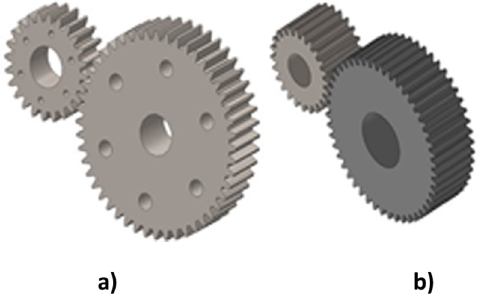
Fig. 1. (a) Solid-hole pro fi le, (b) Solid pro fi le.